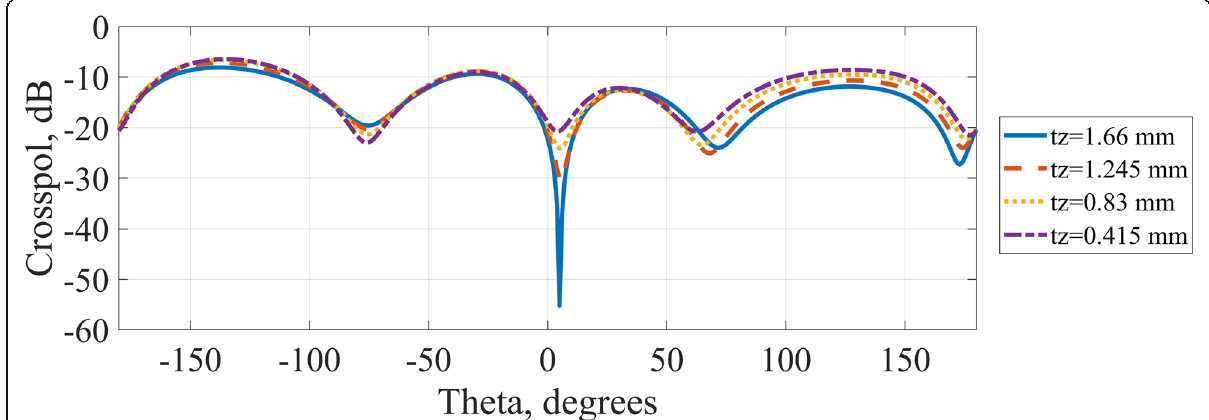
Fig. 8 Effect of the variation of tz (transition length) on cross-polar level for Phi90